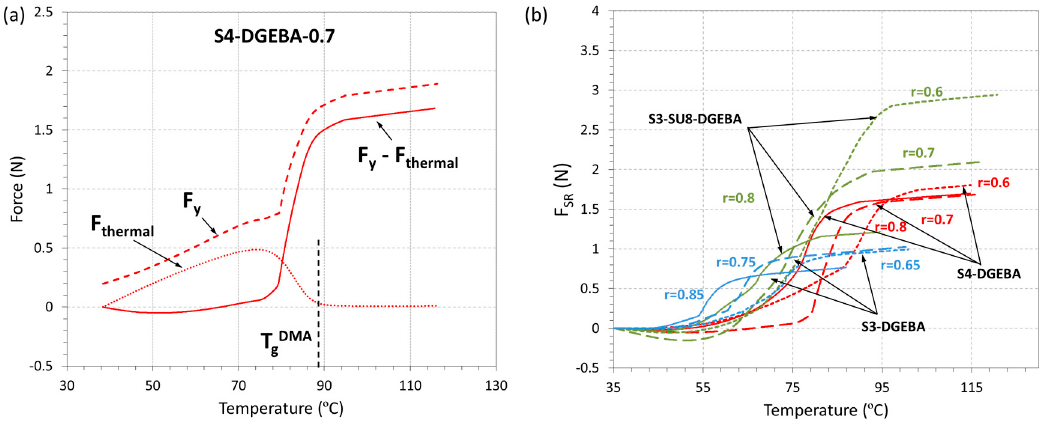
Figure 10. Shape-memory fully-constrained recovery experiments: ( a ) thermal force subtraction process; ( b ) force generated after subtracting the thermal contribution. process; ( b ) force generated after subtracting the thermal contribution.